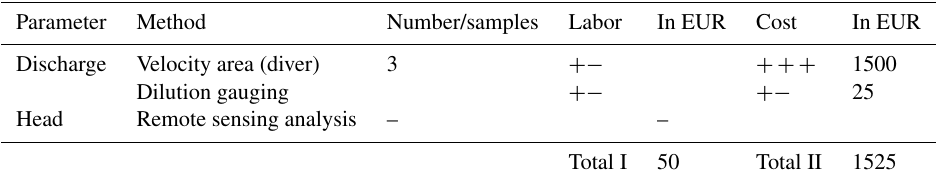
Greenness index Erosion and sedimentation